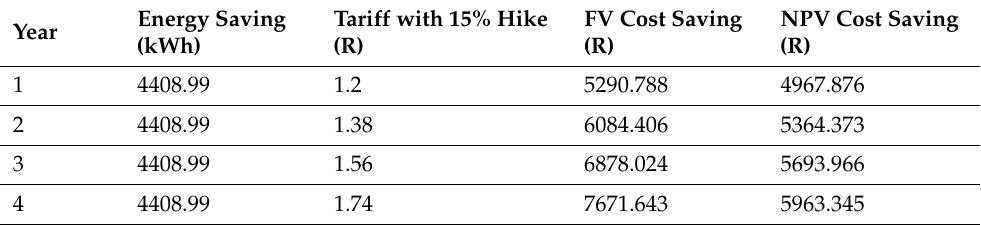
Table 4. Life-cycle cost analysis of the